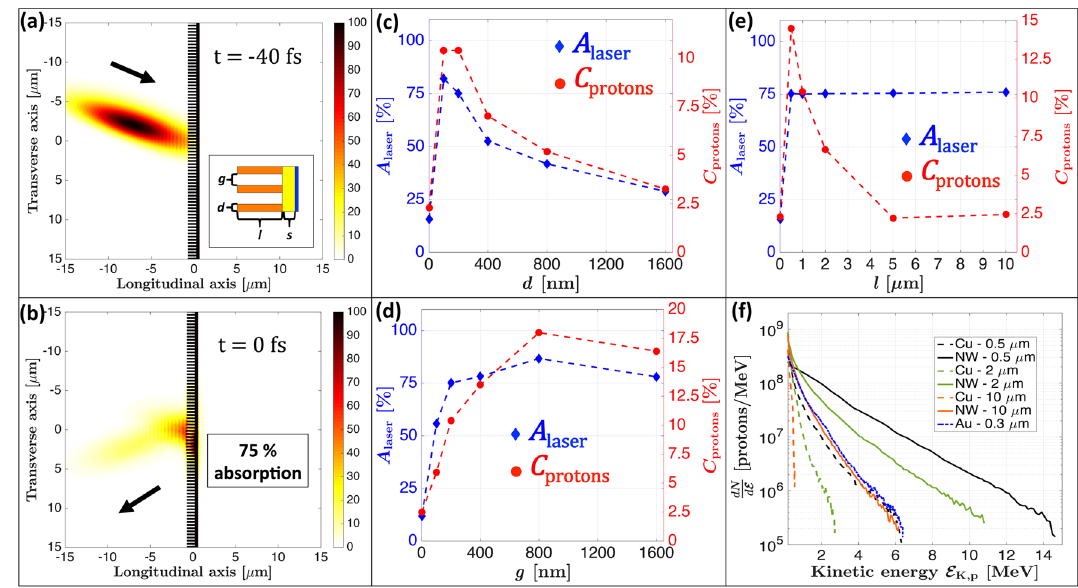
Figure 1. Numerical optimization of NW geometry through PIC simulations using the 2D3V PICLS code. ( a ) EM intensity and simulated target shown just before the laser interaction at t percentage of maximum intensity. The inset is a NW scheme defining the geometry parameters l , d and g ; target is composed of copper NW (orange), gold substrate (yellow) and a proton layer (blue). ( b ) EM intensity and simulated target shown during the laser-target interaction at t (blue diamonds—left scale) and laser-to-proton conversion efficiency (red points—right scale) for different NW ( c ) diameters d , ( d ) gaps g and ( e ) lengths l . ( f ) Simulated proton spectra for NWs with d values as the experimental working point) and three different NW lengths of 0.5, 2 and 10 µ m (solid lines), along with their thickness-equivalent Cu reference foils and the bare Au substrate of 0.3 µ m (dotted